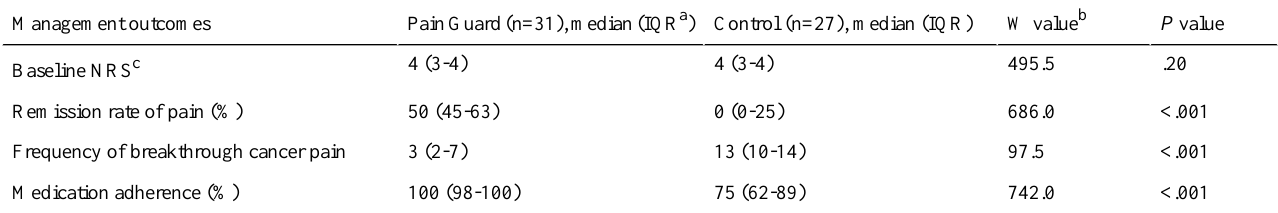
Table 2. Management outcome comparisons between the Pain Guard and control groups